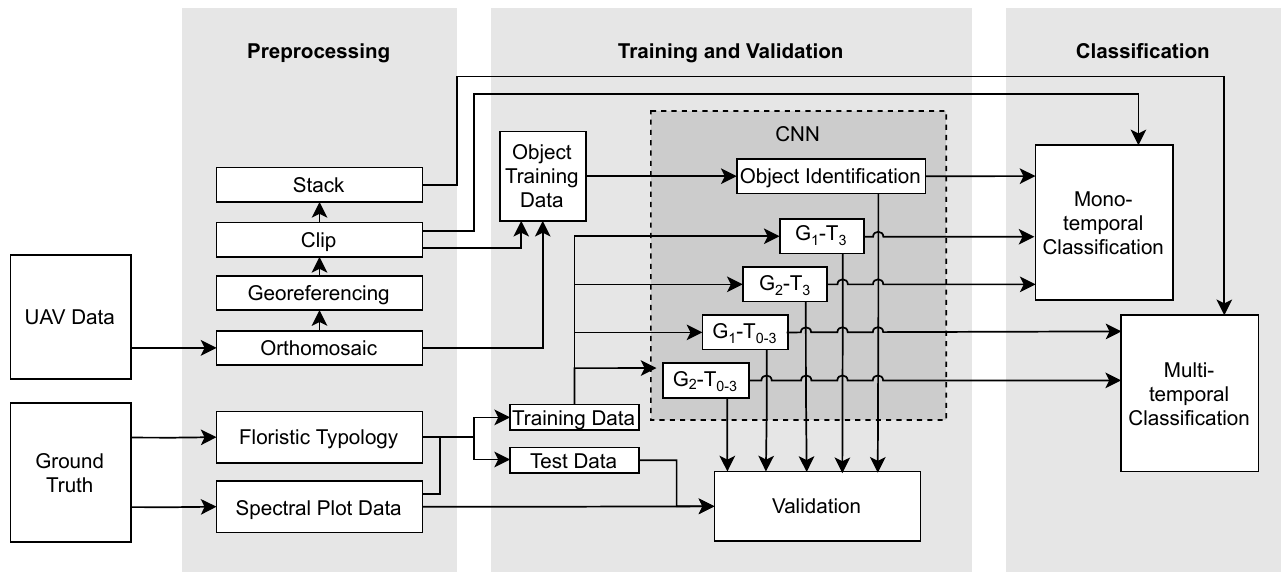
Figure 2. Schematic workflow of preprocessing, training, validation, and